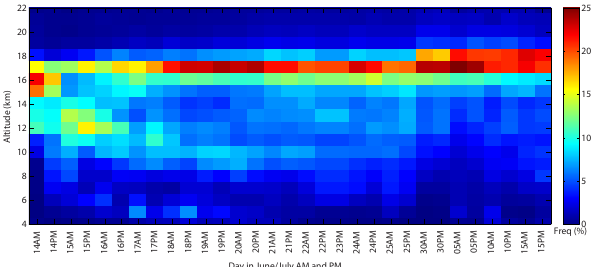
Fig. 13. Frequency of the IASI retrieved SO 2 plume height altitude as a function of time for 14 June to 15 July 2011.